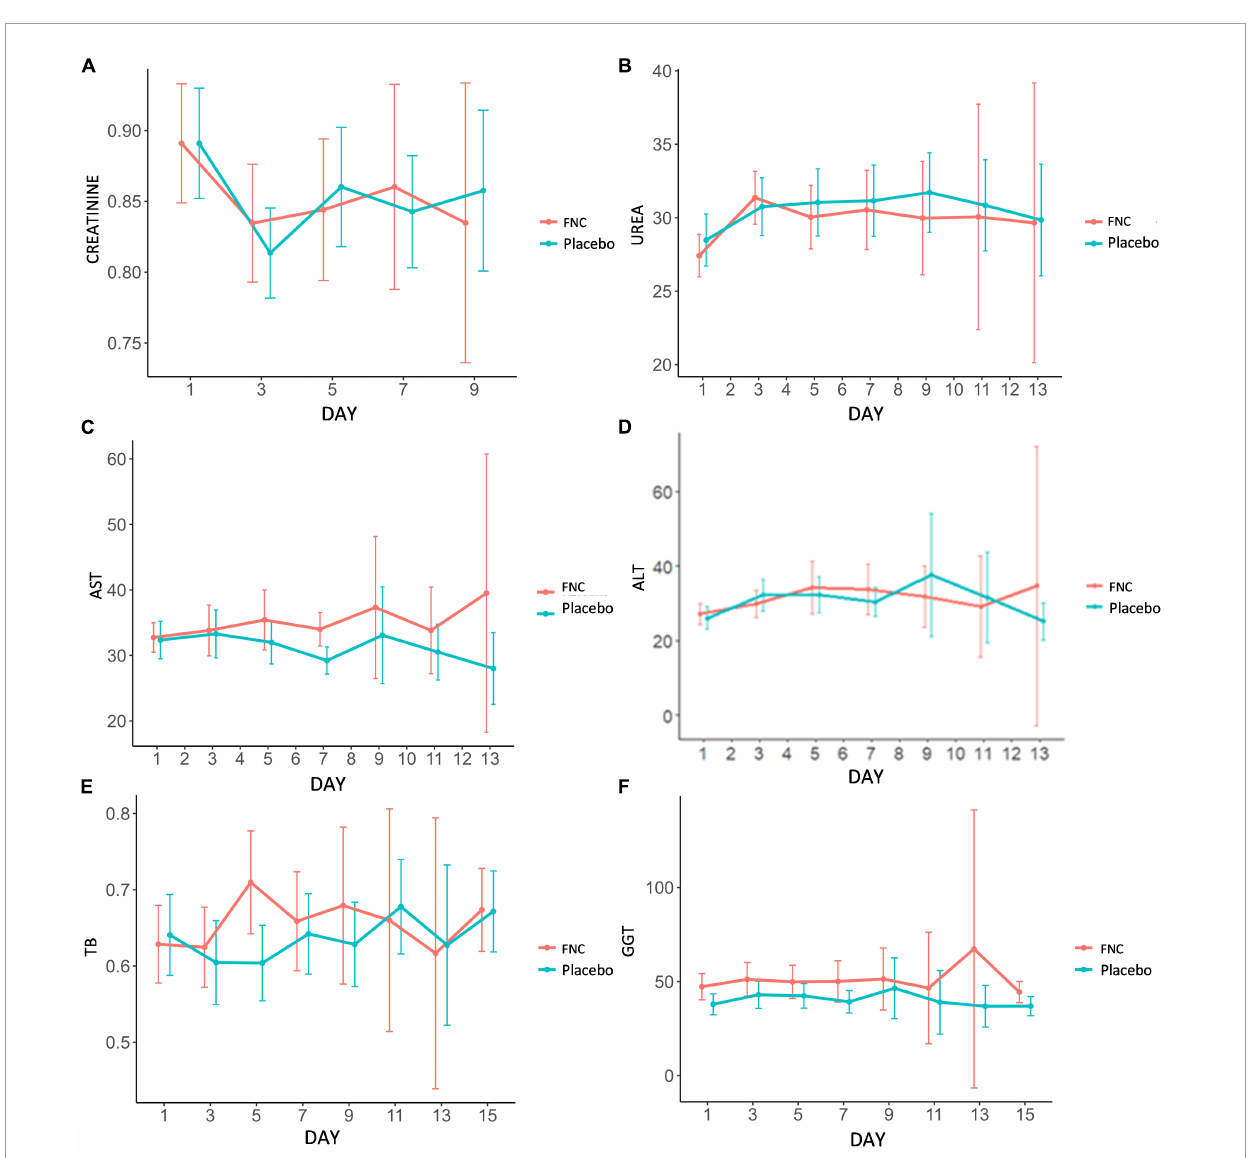
FIGURE5 During the treatment, the dynamic changes in kidney and liver markers: (A) Creatinine, (B) urea, (C) ALT, (D) AST, (E) BT, and (F) GGT of the patients in the FNC group and patients in the placebo group. Data are median (SD) (Red line: FNC; Blue line: PLACEBO).